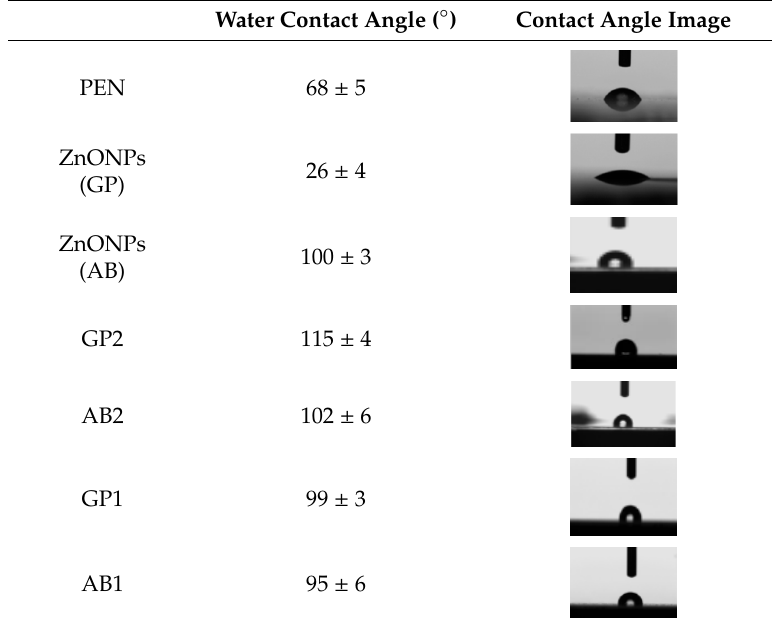
Table 2. Contact angle characterization of the coatings.